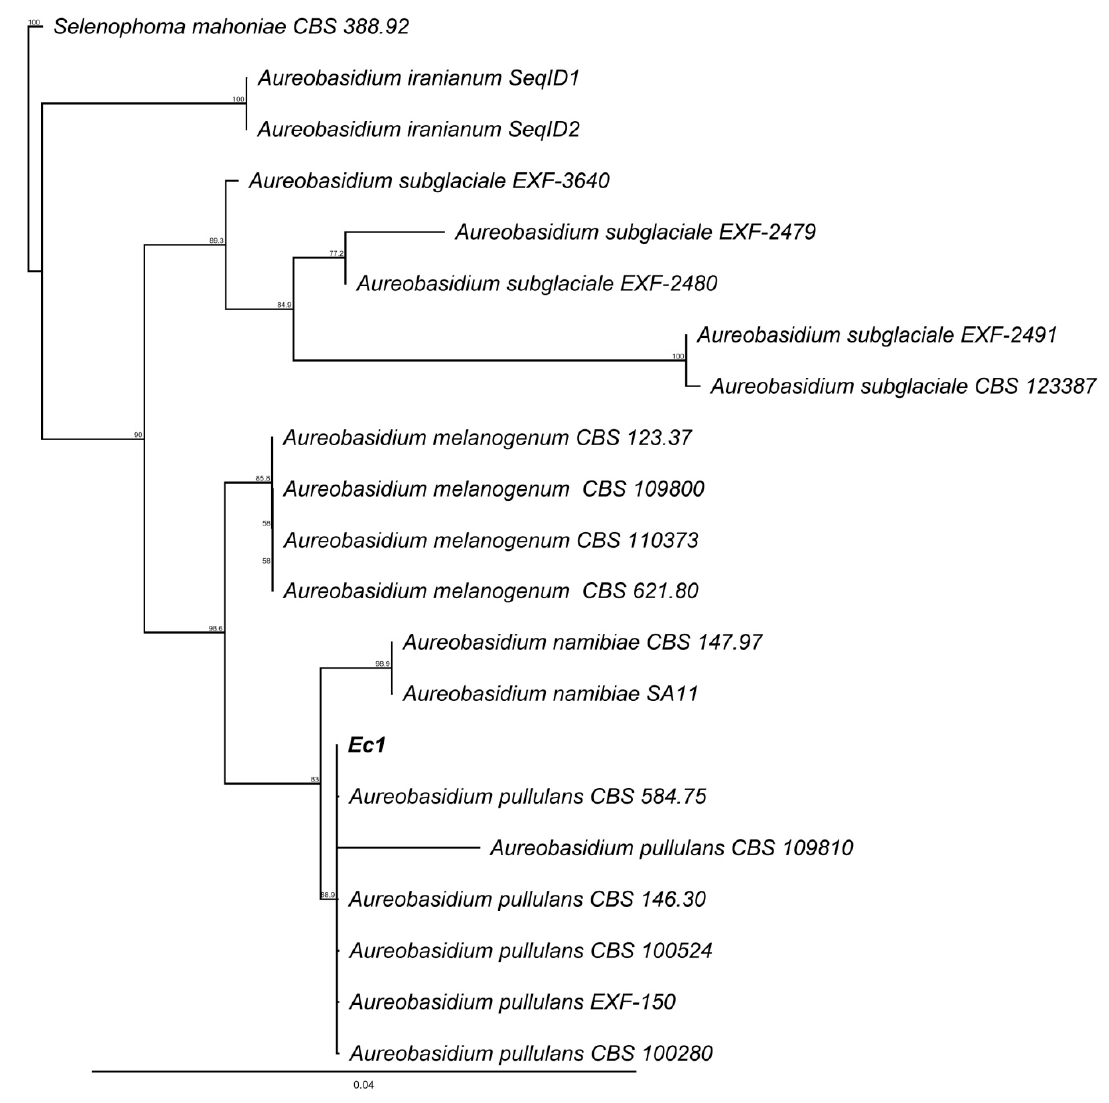
Figure 6. Neighbor-joining tree based on fungal internal transcribed spacer (ITS) sequences of Ec1, Aureobasidium spp. and Selenophoma mahoniae as outgroup. Numbers labeled at each node indicate bootstrap value (%) from 1000 replicated.